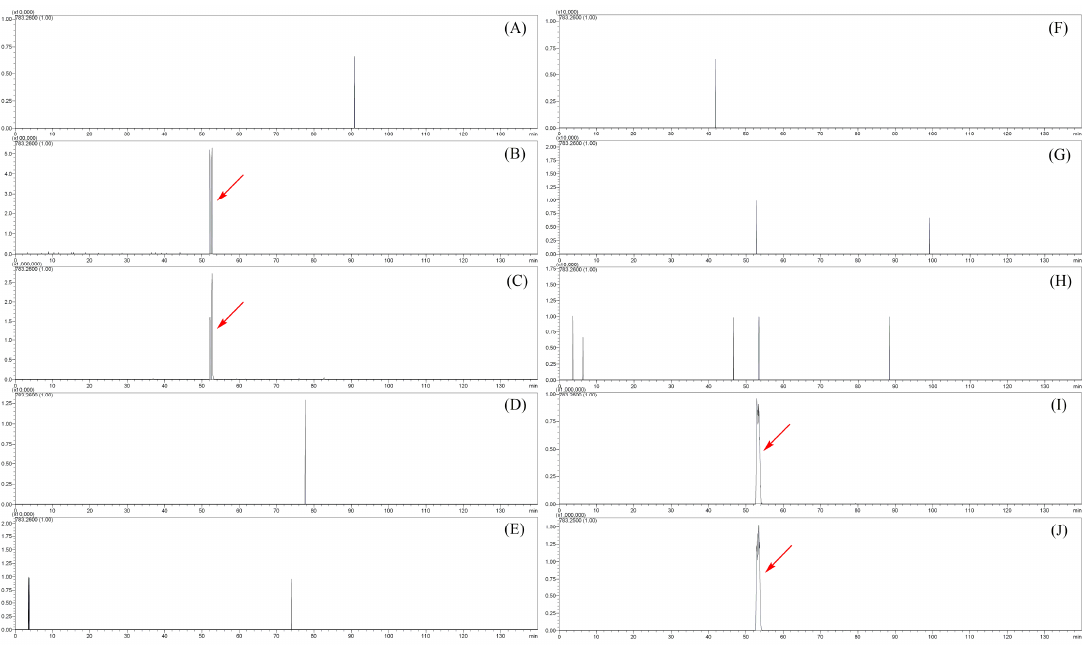
Figure 5. The extract ion flow chromatography (EIC) at m/z 471.1500 of sibirioside A in different biological samples. ( A ) plasma; ( B ) urine; ( C ) feces; ( D ) heart; ( E ) liver; ( F ) spleen; ( G ) lung; ( H ) kidney; ( I ) stomach; ( J ) small intestine.